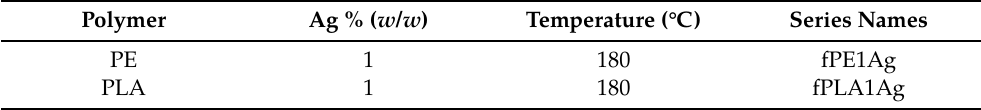
Table 4. Processing parameters for melt-spinning of silver additive (Ag) containing